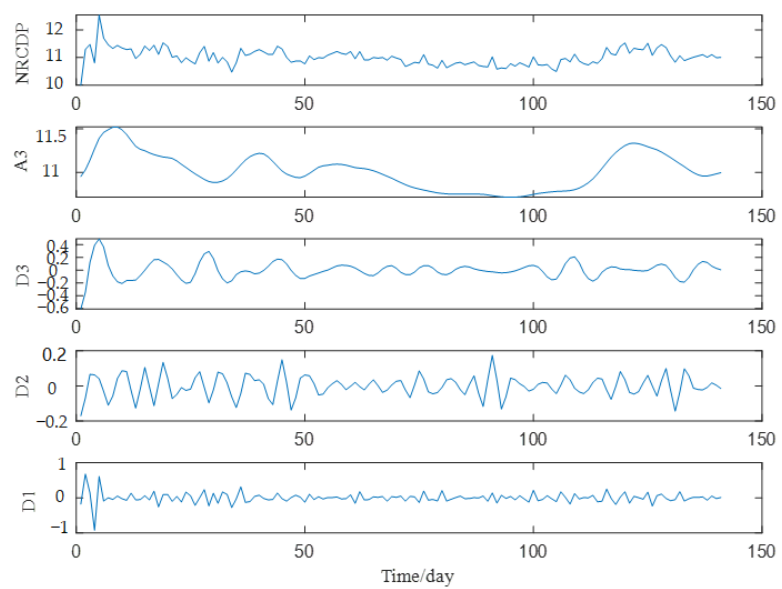
Figure 6. The wavelet decomposition results of the NRCDP data.